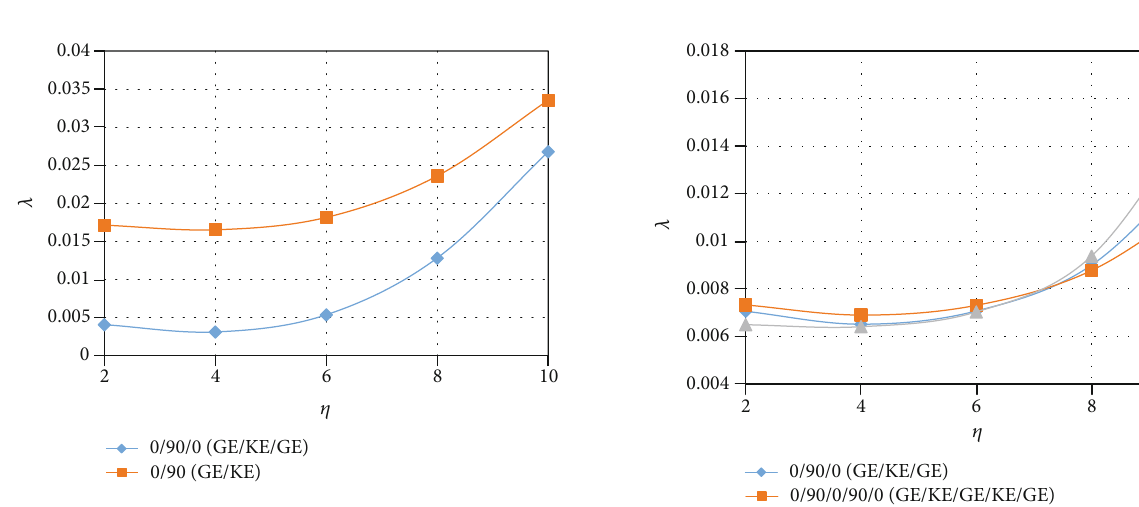
Figure 9: Variation of fundamental frequency parameter and circumferential node number of 3- and 2-layered annular circular plates.